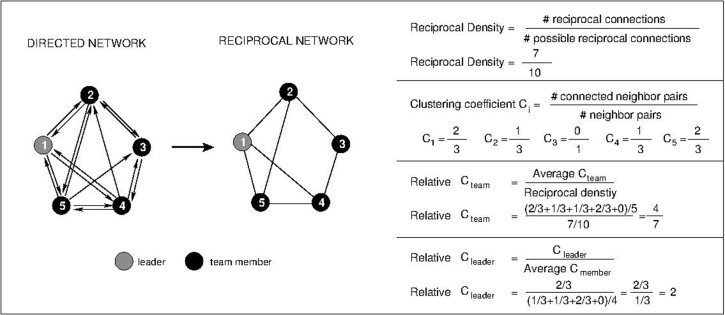
Illustration of social network analysis.As an example of a directed network of relationships between pairs of neighbors taken from the survey (left diagram), we show how to obtain the reciprocal network and different network metrics: reciprocal density, the local clustering coefficient Ci for each team member, the relative clustering coefficient of the team Cteam and the relative clustering of the leader Cleader. In the left diagram, the directed network shows only positive interactions (‘Yes’ answers in the survey). Black nodes mark regular team members, whereas the grey node indicates the team leader. If two team members A and B have positive interactions A -> B and B-> A in the directed network, then there is a reciprocal interaction between A and B (right diagram). From the reciprocal network of interactions, we computed the quantities of interest as indicated in the diagram. The symbol ‘#’ indicates total numbers.